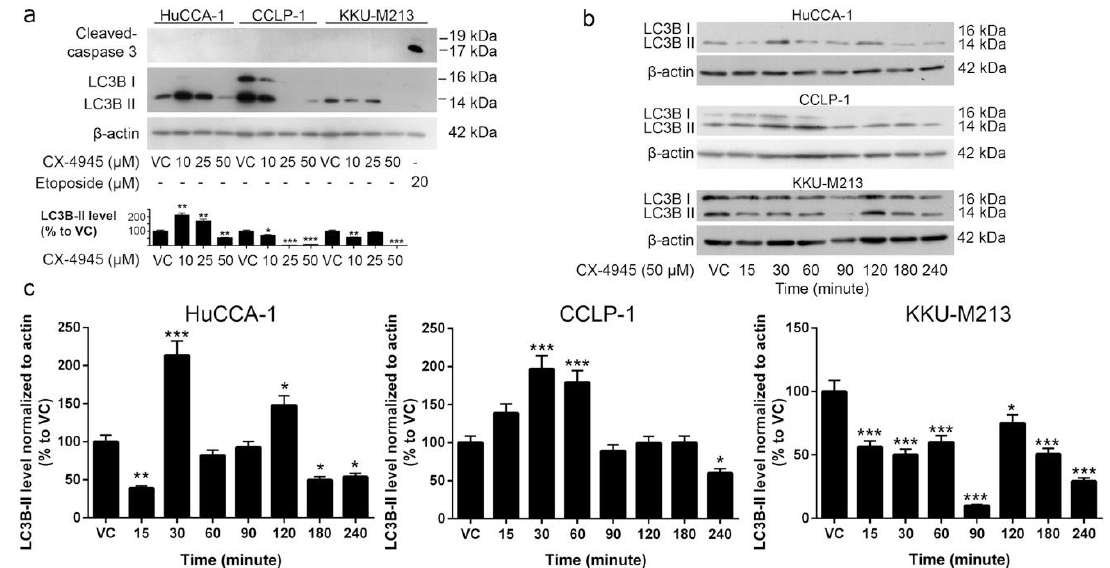
Figure 5. CX-4945 induced non-apoptotic, non-autophagic cell death. ( a ) The apoptotic marker, cleaved caspase-3, and autophagic marker, LC3B-II, was not increased after 48 h of CX-4945 treatment when dead cells and vacuoles were observed. ( b , c ) The level of LC3B-II in HuCCA-1 and CCLP-1 cells increased at early time points, and then decreased after 3 h of 50 µM CX-4945 treatment in HuCCA-1 cells and after 4 h in CCLP-1 cells. The level of LC3B-II in KKU-M213 decreased as soon as 15 min after 50 µM CX-4945 treatment. VC; vehicle control, *; p < 0.05, **; p < 0.01, ***; p < 0.001. All experiments were performed with at least three replicates. Graphs were plotted as mean ± SEM.